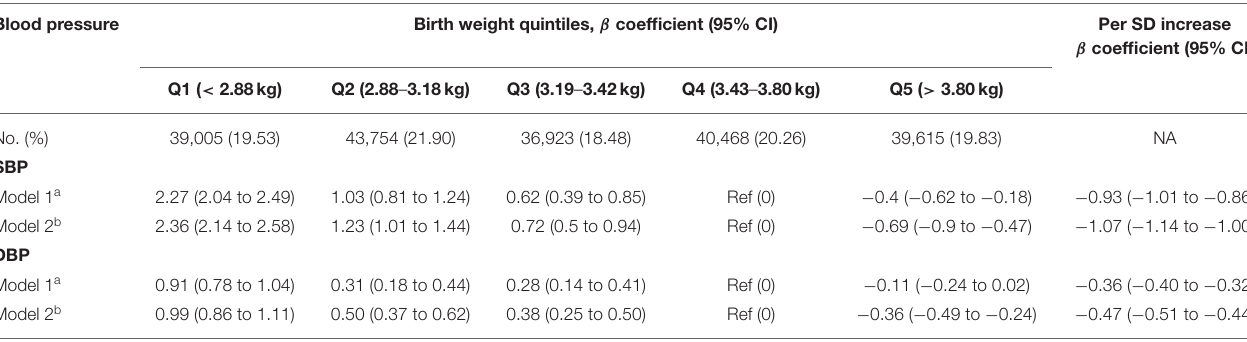
TABLE 3 | Associations between birth weight and blood pressure.